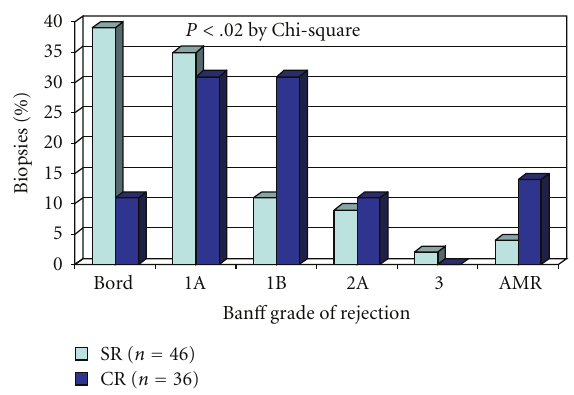
Figure 1: Distribution of Ban ff classification of acute rejection. Ban ff borderline changes were included with the rejection groups. The SR group had milder grades of acute cellular rejection compared to the CR group ( P < . 02 by chi-square). AMR occurred in 14% of the CR group and 4% of the SR group (not significant). SR: subclinical rejection, CR: clinical rejection, AMR: antibody- mediated acute rejection, Bord: borderline change by Ban ff criteria.